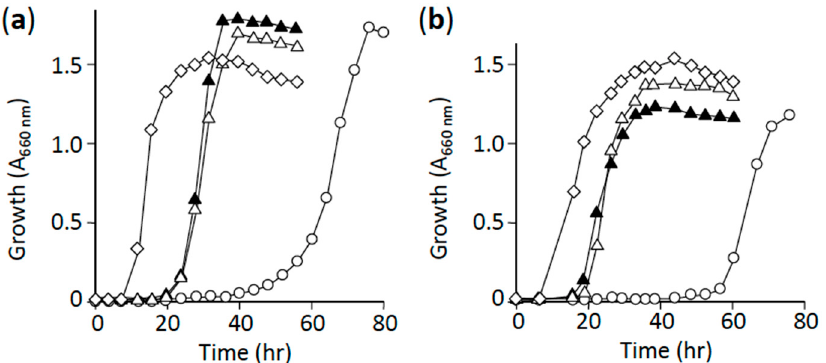
Figure 4. Growth of L-alanine prototrophic suppressor mutants and their cognate isogenic mutants in liquid minimal medium. ( a ) Clone #8-2 and its isogenic mutant #8-2M. ( b ) Clone #13-1 and its isogenic mutant #13-1M. Symbols: open diamonds, W3110; open circles, HYE032; open triangles, original L-alanine suppressors #8-2 ( a ) and #13-1 ( b ); closed triangles, respective isogenic mutants #8-2M ( a ) and #13-1M ( b ). The figure shows representative results from 3 independent experiments.